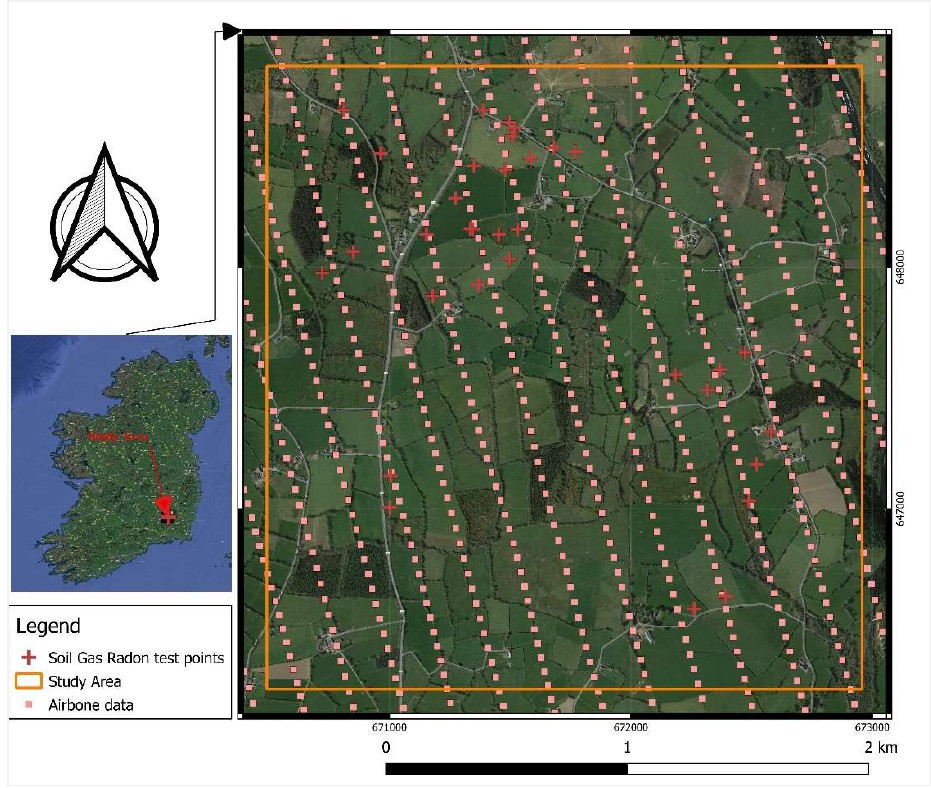
Figure 1. Satellite image of the study area with the location of the soil gas radon testing and airborne radiometric survey points.